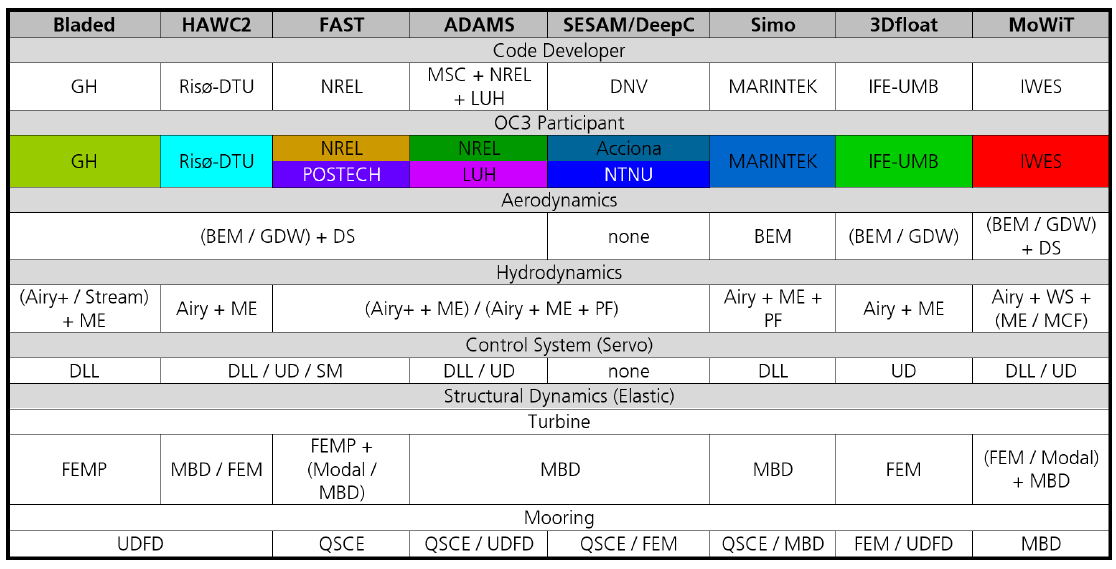
Figure 1. Aero-hydro-servo-elastic modeling approaches of the OC3 phase IV participants [7] and